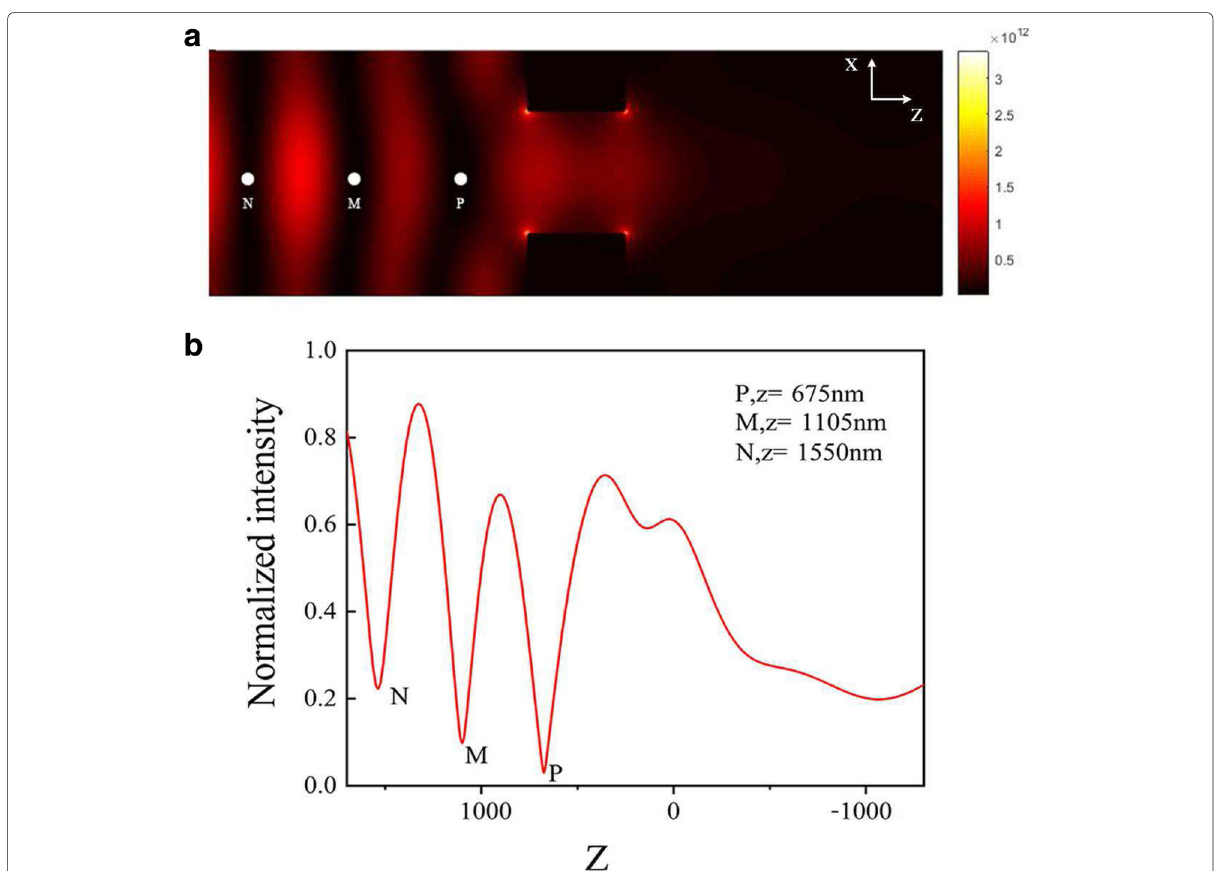
Fig. 3 a Electromagnetic field intensity | E | 2 distribution in the X - Z plane at Y = 0 at λ = 696 nm. b Normalized intensity distributions of | E | 2 versus Z with X = 0 and Y = 0 in the X - Z plane